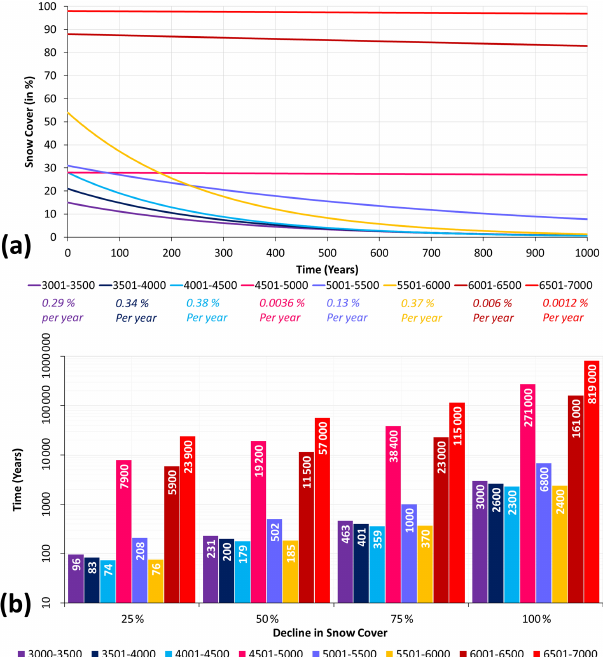
Figure 7. The results from the linear trend analysis of the snow cover change (mainly reduction) during 2000–2017 and in the sub- sequent years over the HKH region and where the trend was found to be statistically significant